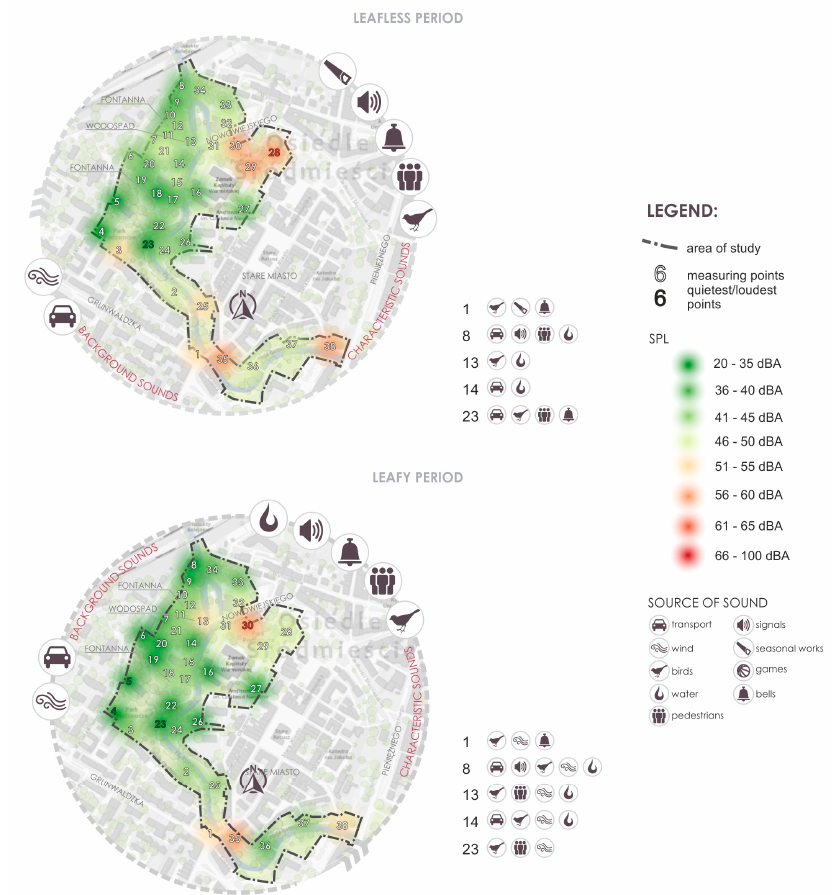
Figure 13. Results of evaluation of the soundscape (SPL measurements and characteristic sounds) presented in the map of the Podzamcze Park in the leafless and leafy period. The loudest areas are located on busy streets and near the car park. In the leafless period, point No. 23 is the quietest, and point No. 28 is the loudest. In the leafy period, points 4, 5, and 23 are the quietest, and point No. 30 is the loudest. Characteristic sounds are described by pictograms for points 1, 8, 13, 14, 23.